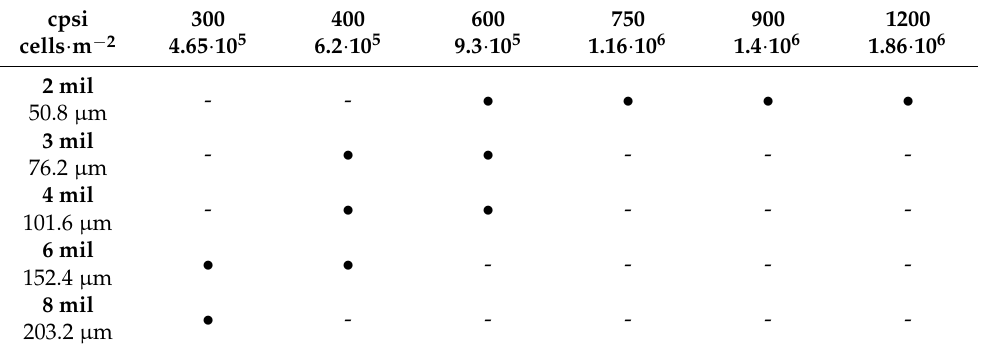
Table 1. Matrix of selected cordierite monoliths to be investigated ( • ) [10,27].